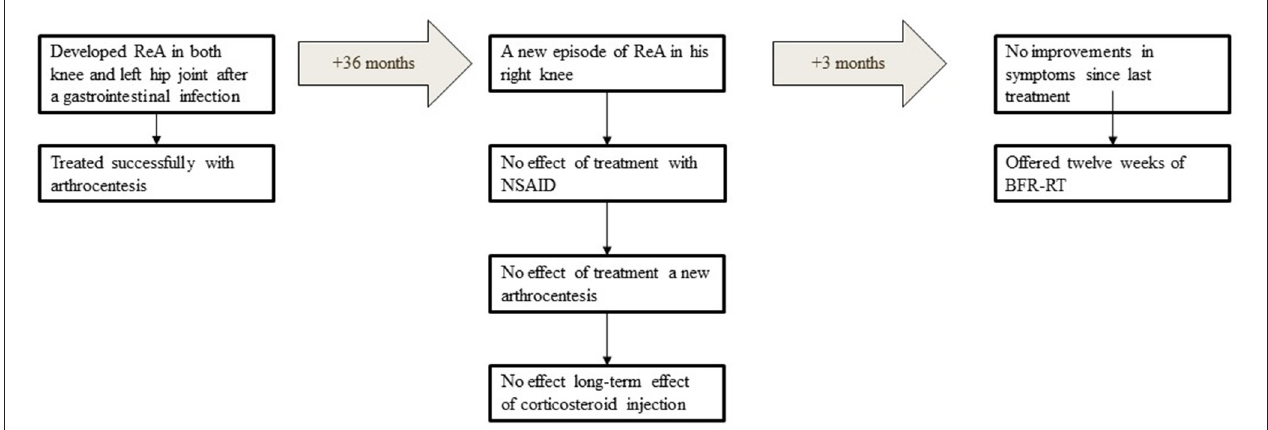
FIGURE 1 | Timeline of the patient history. ReA, reactive arthritis; NSAID, non-steroid anti-flammatory drugs; BFR-RT, blood flow restricted exercise.